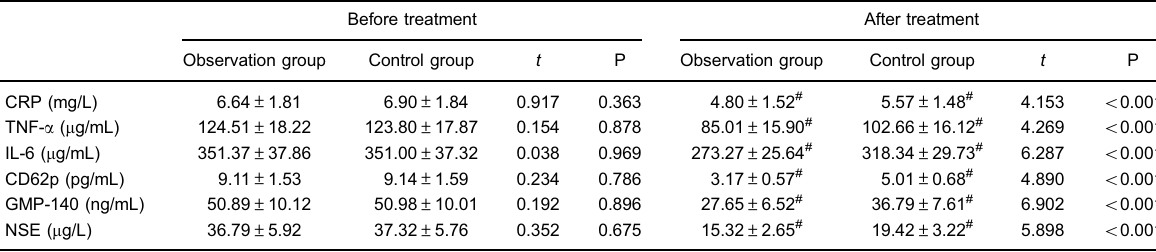
Table 3. Comparison of in fl ammatory factors and NSE before and after treatment of patients with cute cerebral infarction treated with alteplase (observation group) or batroxobin (control group). Before treatment After treatment Observation group Observation